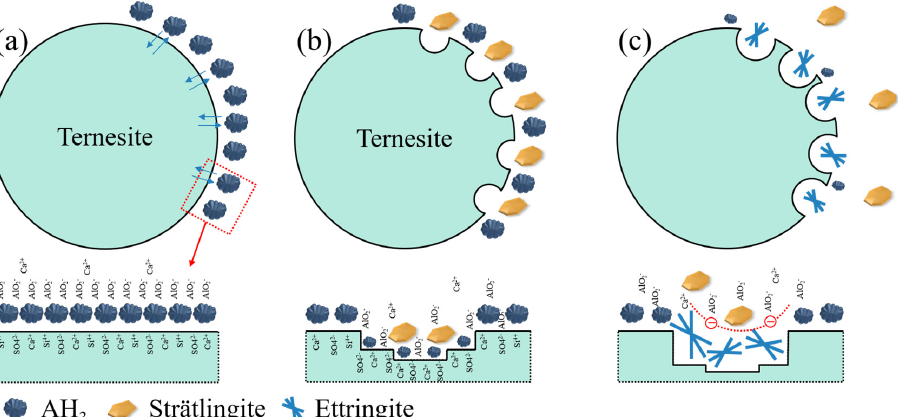
Figure 10. Hydration scheme of ternesite; ( a ) the AH 3 touches the surface of ternesite; ( b ) ternesite reacts with AH 3 to form strätlingite; ( c ) the remaining AH 3 reacts with CaSO 4 to form ettringite.